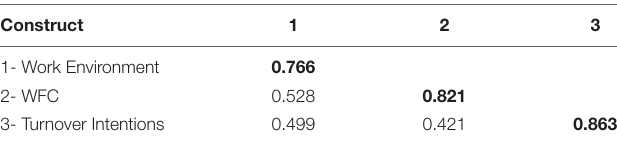
TABLE 2 | Discriminant validity based on Fornell–Larcker